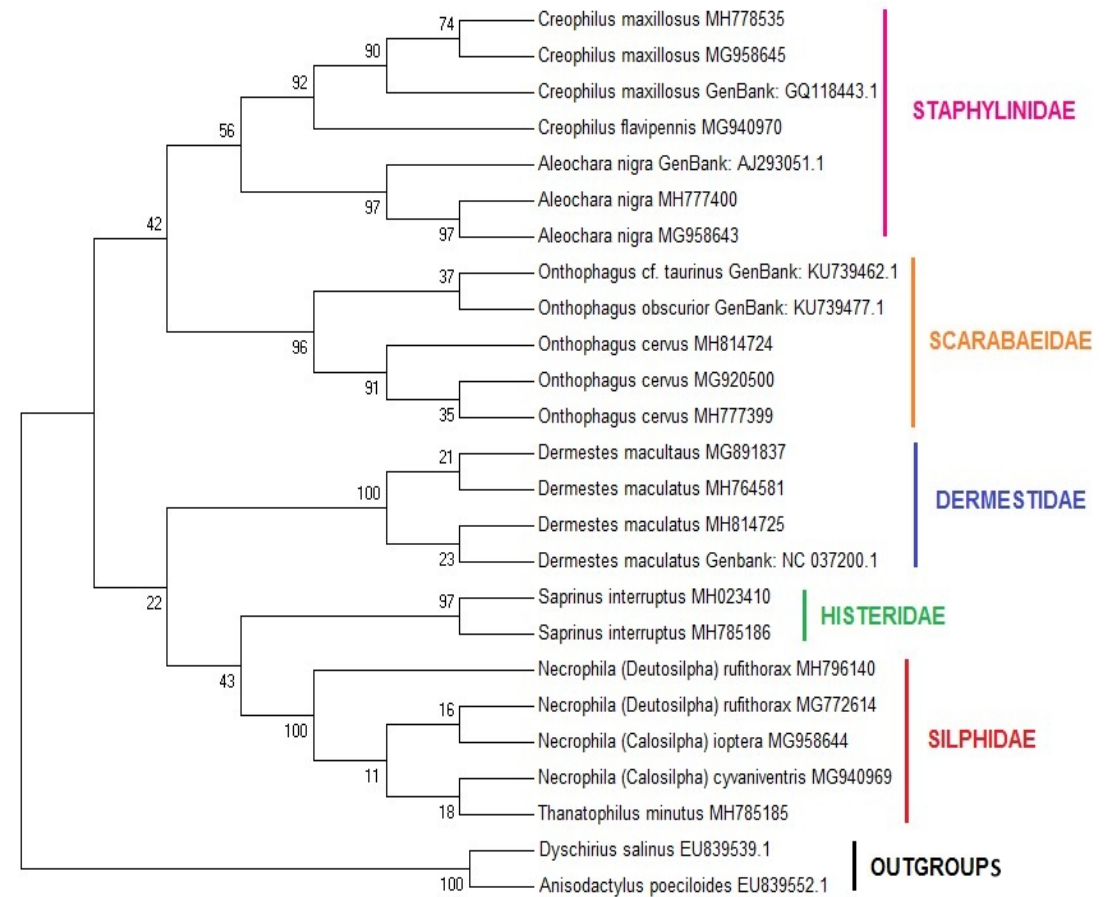
Figure 4. Maximum likelihood (ML) for beetle species of forensic interest in India inferred from COII gene sequence.